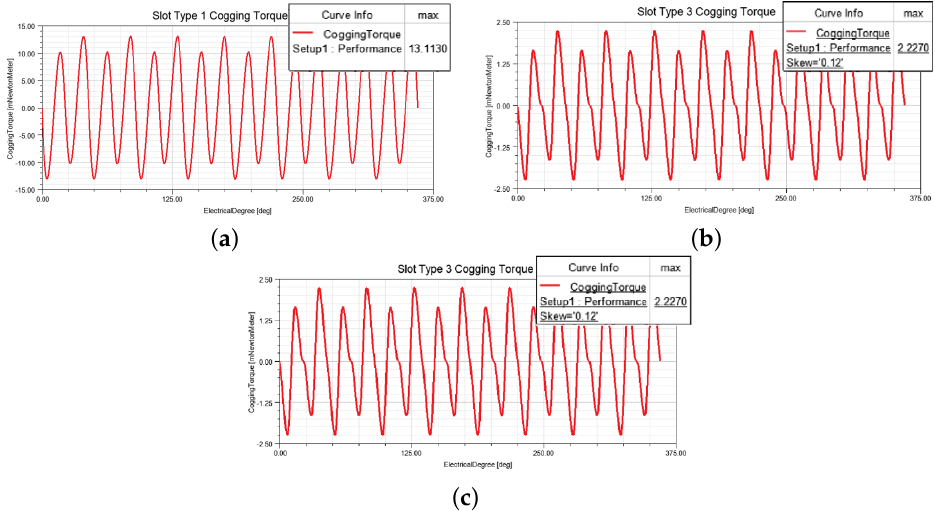
Figure 17. Effect of the stator slot types on cogging torque for ( a ) Slot − 1, ( b ) Slot − 3, and ( c ) Slot −